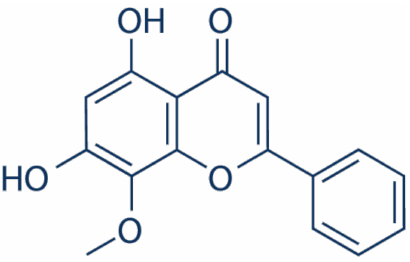
Figure 6. The chemical structure of